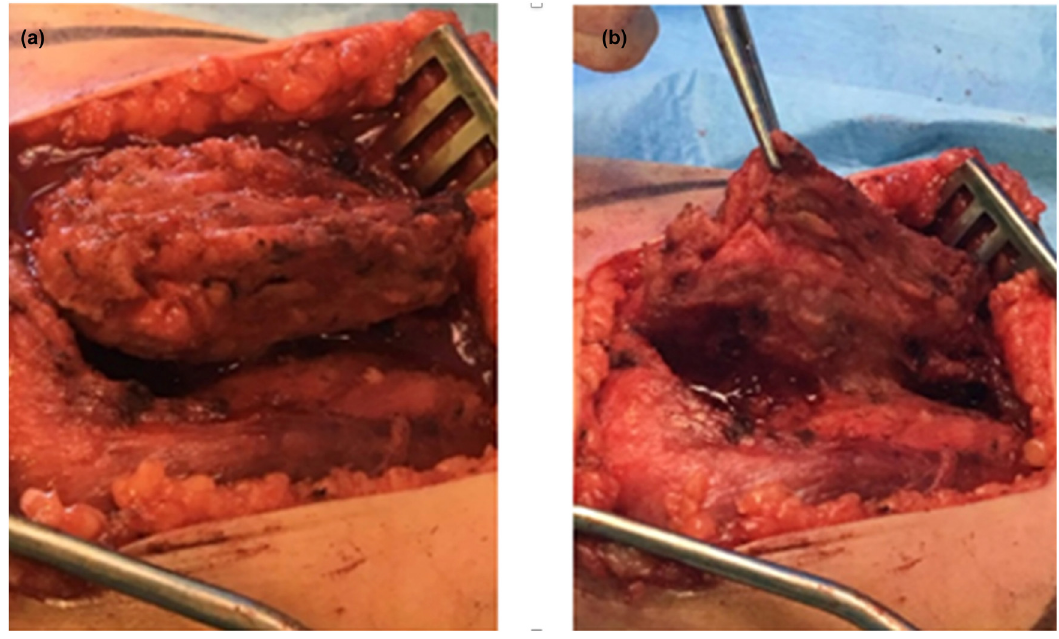
Figure 3: Intraoperative images from the resection surgery. ( a ) Isolation of the mass; ( b ) mass